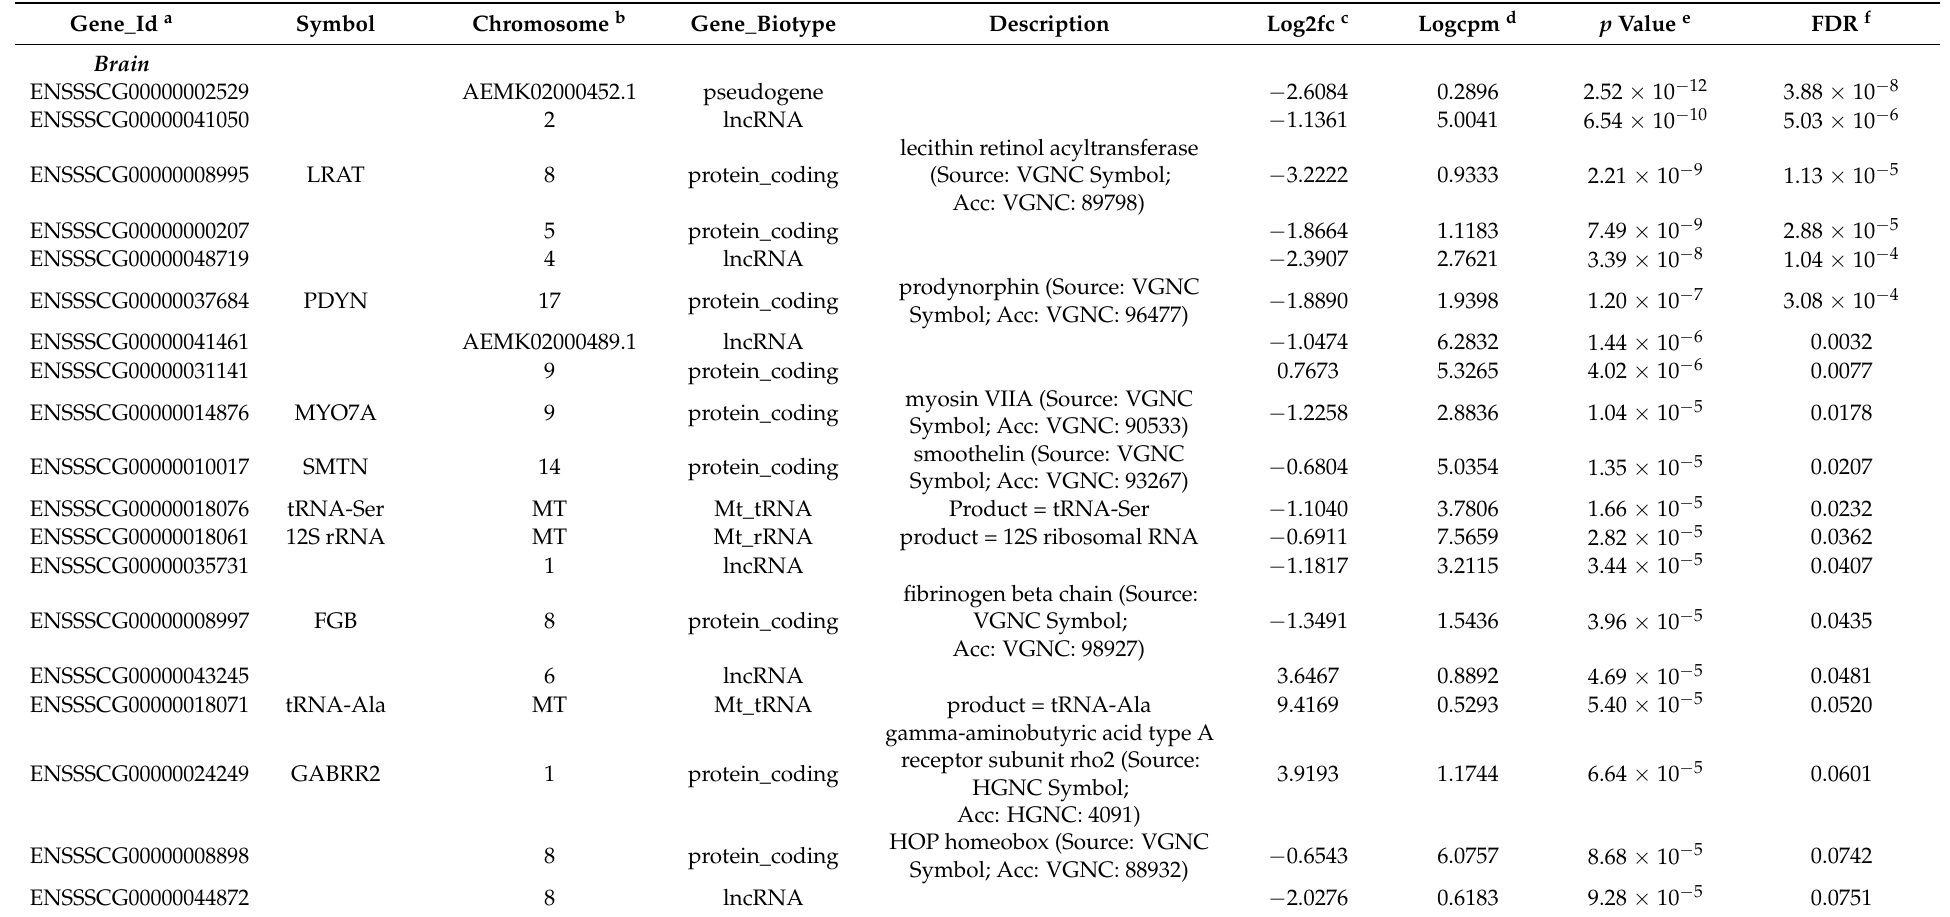
Table 1. Differentially expressed genes between mtDNA-supplemented and control pig brain, heart and liver